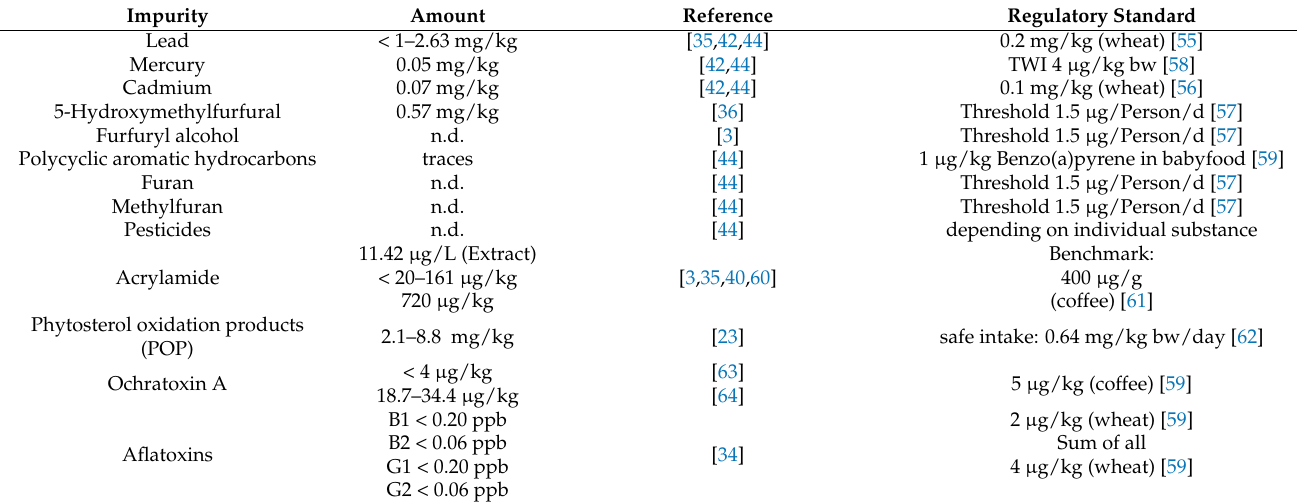
Table 3. Contaminants of coffee silver skin. If not stated otherwise the regulatory standard is a